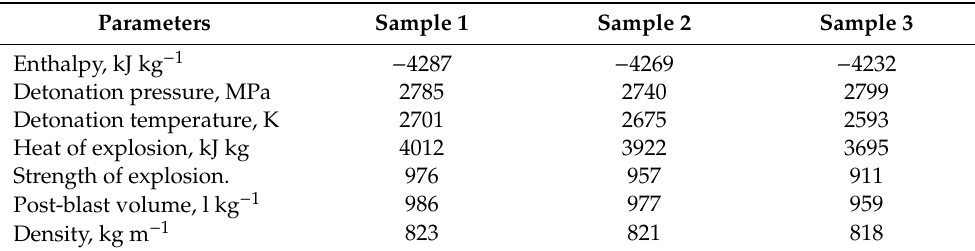
Table 2. Average velocity of detonation (VOD) for the investigated